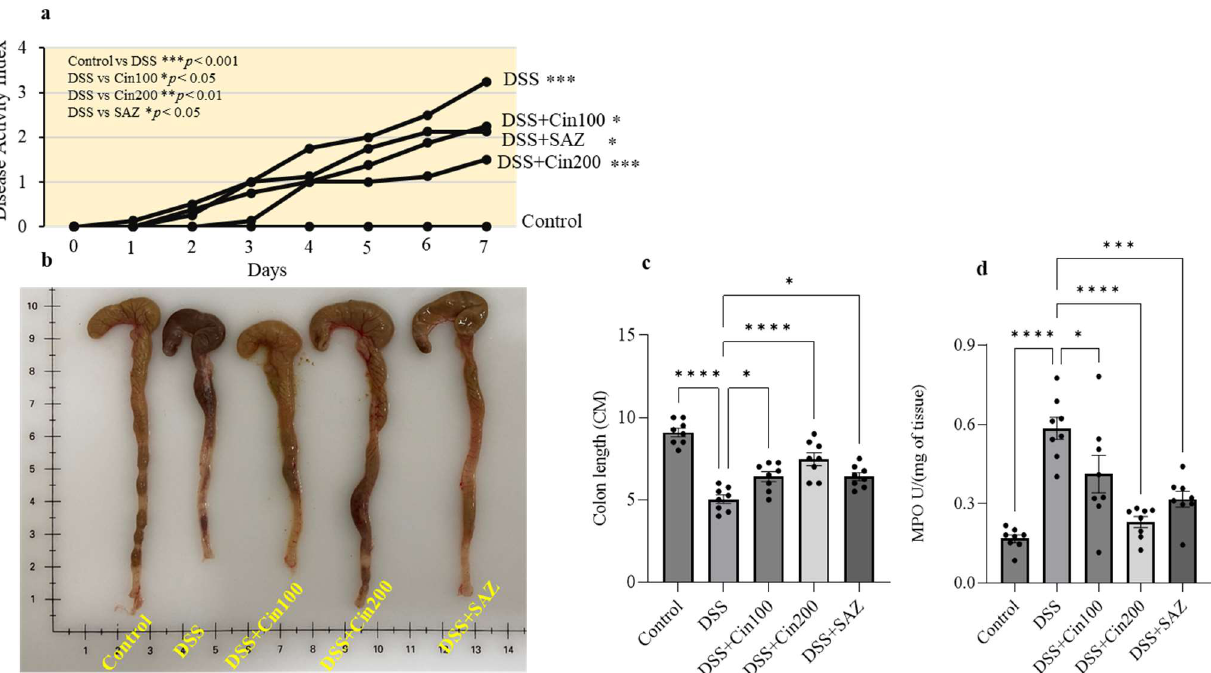
Figure 2. Effect of 1,8-cineole on the disease activity index (DAI), colonic length, and myeloperoxidase (MPO) activity. DSS administration significantly ( a ) increased the DAI, ( b , c ) decreased colonic length, and ( d ) increased MPO activity. 1,8-cineole treatment significantly prevented ( a ) the increase in DAI, ( b , c ) the decrease in colonic length, and ( d ) the increase in MPO enzyme activity. Data were obtained from n = 8 animals in each group. The results are expressed as the means ± SEM. * p ≤ 0.05, ** p ≤ 0.01, *** p ≤ 0.001, and **** p ≤ 0.0001.